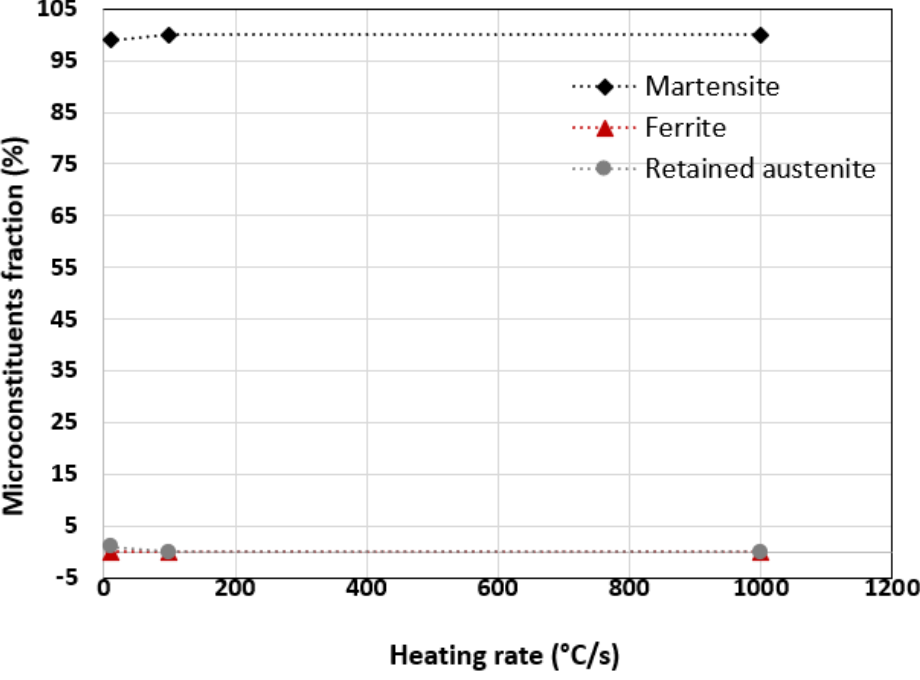
Figure 16. Microstructural evolution at different HRs for peak temperature at Ac3: 950 °C (data from [57]; steel chemical composition: 0.2% C + Mo + Ti + Nb).